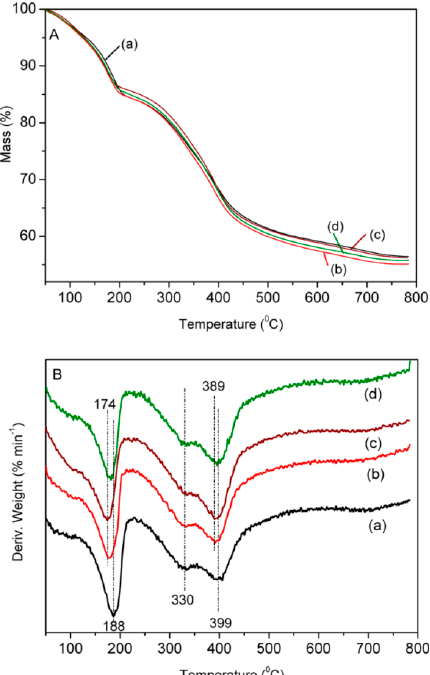
Figure 5. A : Thermogravimetric analysis (TGA) and B : differential thermogravimetry (DTG) curves of